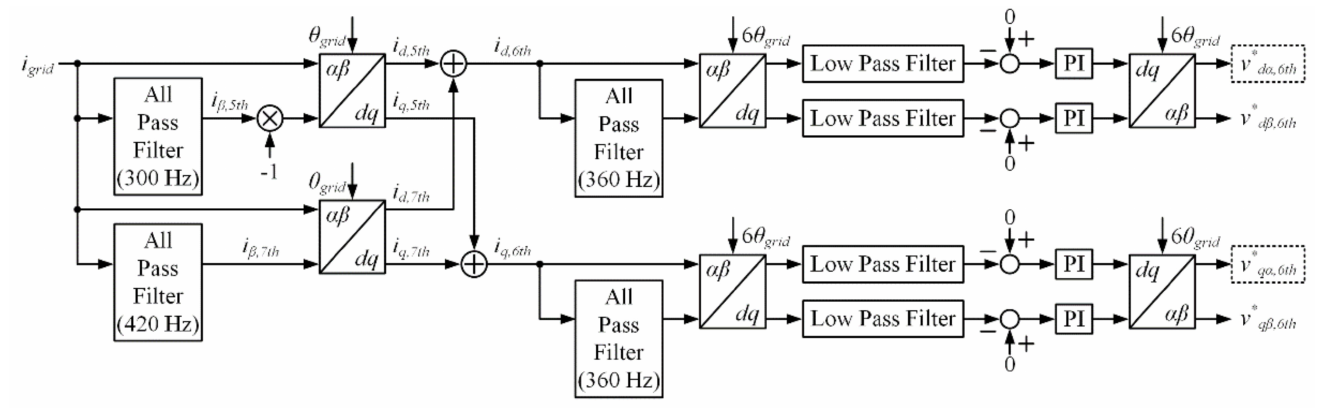
Figure 5. Control block diagram for reduction of sixth-order harmonic